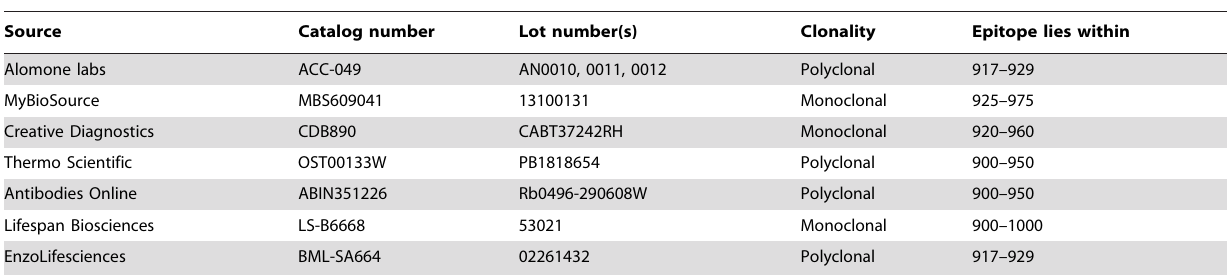
Table 1. Source and characteristics of the antibodies.